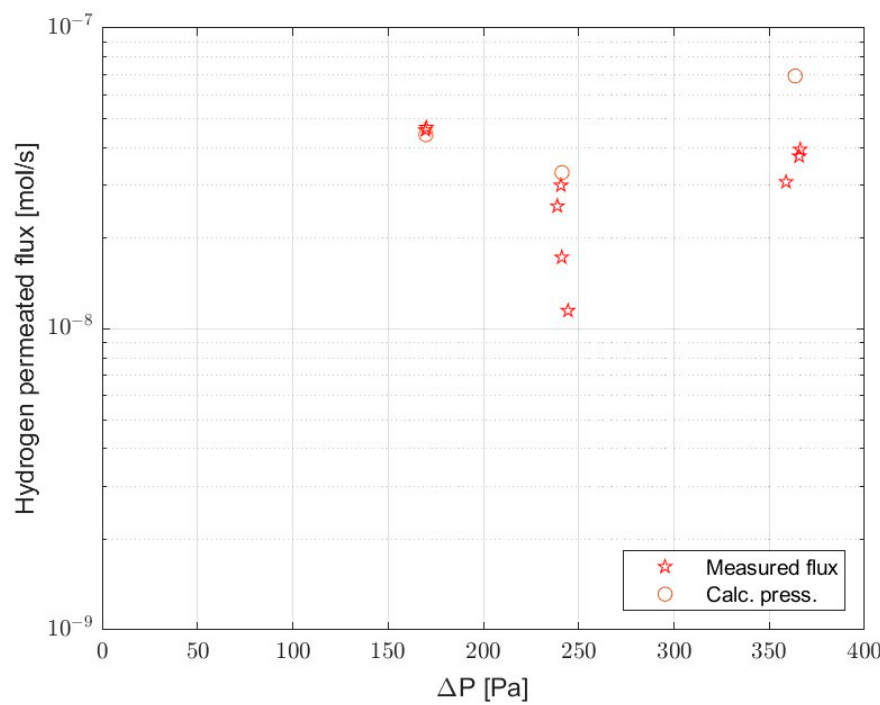
Figure 6. Hydrogen permeated fluxes for the 3 tests (stars) compared with the fluxes calculated from the data of the pressurization tests (circles). The X-axis refers to the pressure difference that drives the permeation (difference between the LiPb at the entrance of the niobium tubes and the pressure in the vacuum chamber).